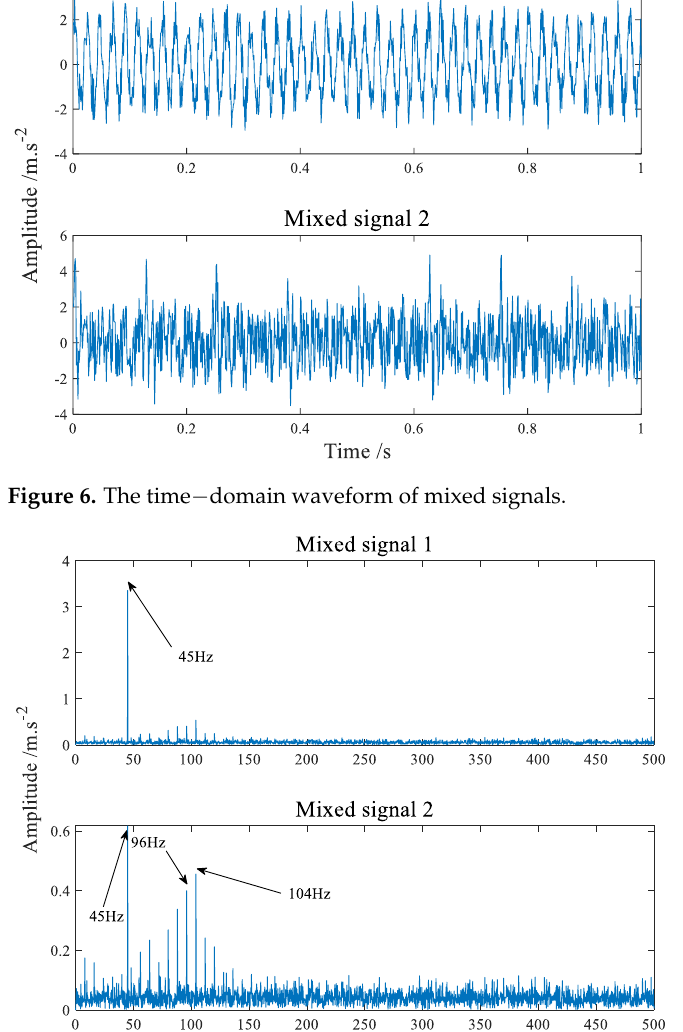
Figure 7. The amplitude spectrum of mixed signals.